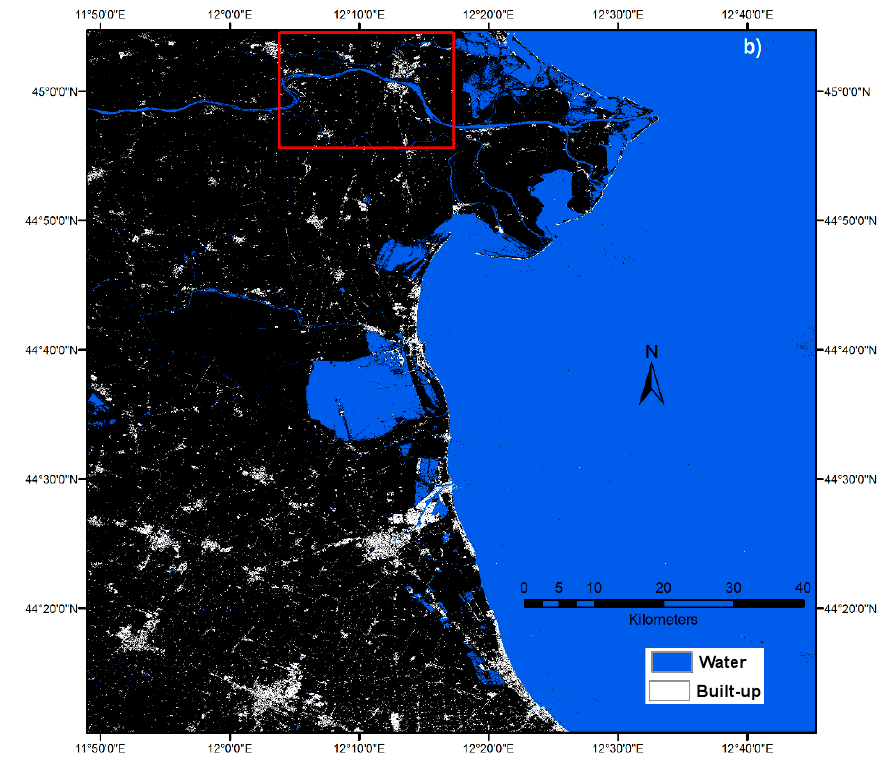
Figure 3. ( a ) Corine Land Cover (CLC) reference set; and ( b ) the classified Sentinel-2 imagery.